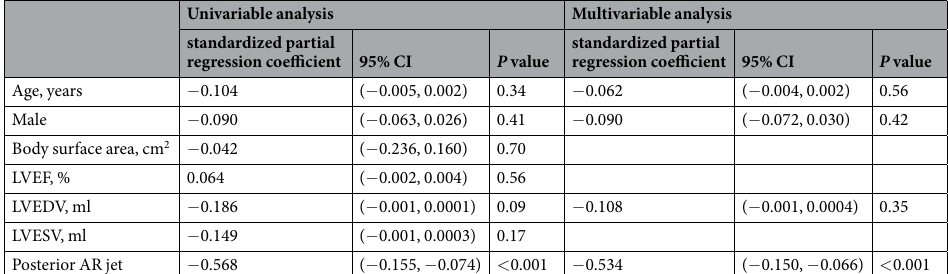
Table 5. Univariable and multivariable analyses of mitral valve opening area/mitral valve annulus area ratio. CI, confidence interval; LVEF, left ventricular ejection fraction; LVEDV, left ventricular end-diastolic volume; LVESV, left ventricular end-systolic volume; AR, aortic regurgitation. Data are presented from the single and multiple regression